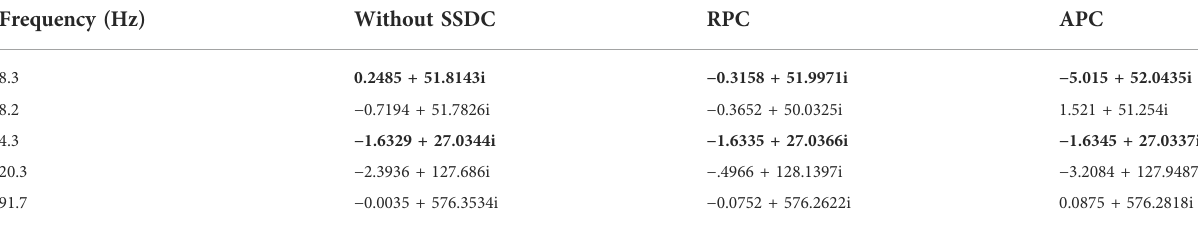
TABLE 5 Eigenvalues of system with SSDC inserted at different points.